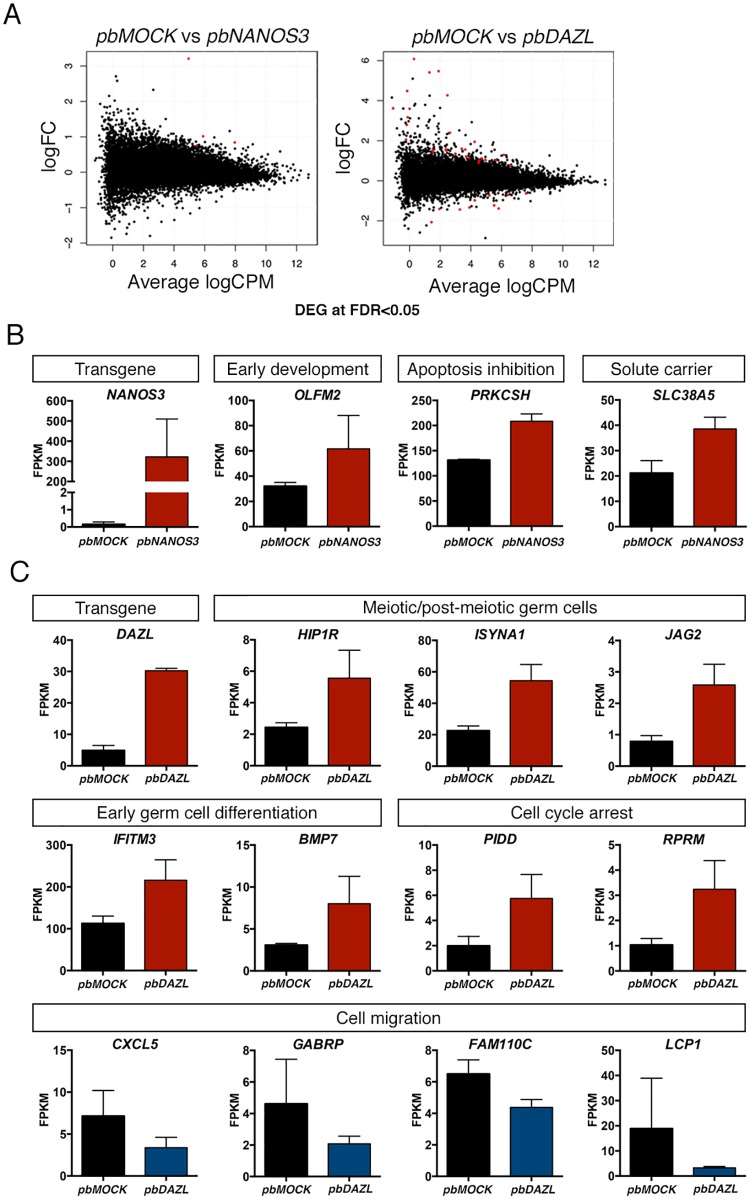
Differentially expressed genes in pbNANOS3 and pbDAZL cells in undifferentiated culture conditions.A) Differential gene expression analysis for transfected cells by mRNA sequencing. Samples from three separate transfections were used at passage 2 after transfection. Results are shown in MA-plot with log fold change (logFC) values in the pbNANOS3 or pbDAZL versus the pbMOCK sample, plotted against average log counts per million (logCPM). Significant genes (FDR < 0.05) are marked as red: pbNANOS3 (4 genes), pbDAZL (38 genes). See also S2 Table. Selected differentially expressed genes for B) pbNANOS3 and C) pbDAZL, with suggested functions. Values are Fragments Per Kilobase Of Exon Per Million Fragments (FPKM), and represented as mean ± SD. See also S1D and S2 Figs.